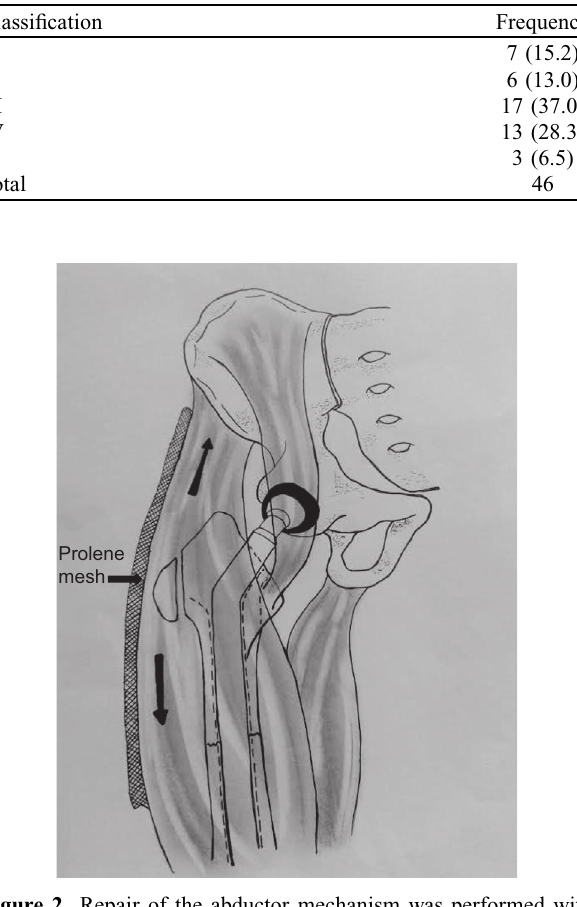
Figure 2. Repair of the abductor mechanism was performed with mesh technique (Prolene (cid:2) (cid:3) Ethicom, Johnson & Johnson, NJ, USA).